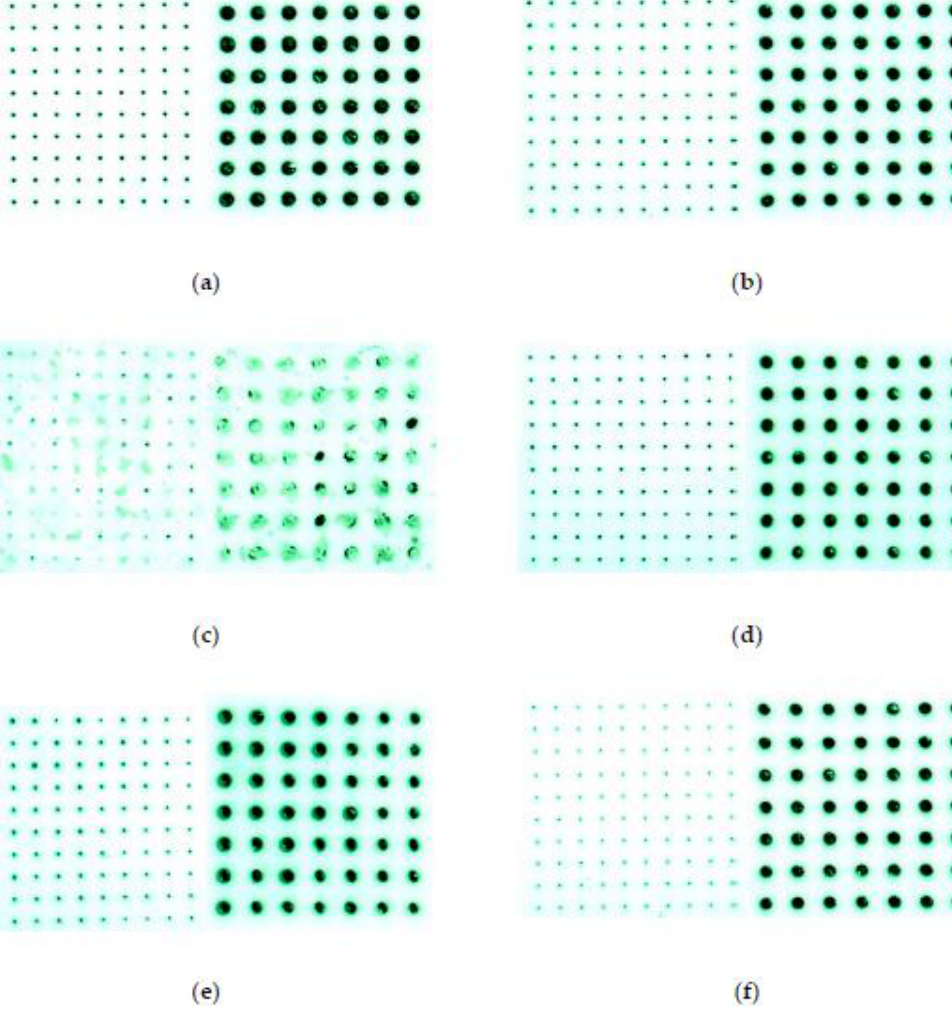
Figure 6. Close-up on the smallest and largest matrixes for each sample, after firing: ( a ) HEC 2 wt%, ( b ) HEC 5 wt%, ( c ) agar-agar, ( d ) gelatin, ( e ) carbon paste and ( f ) no SVM.